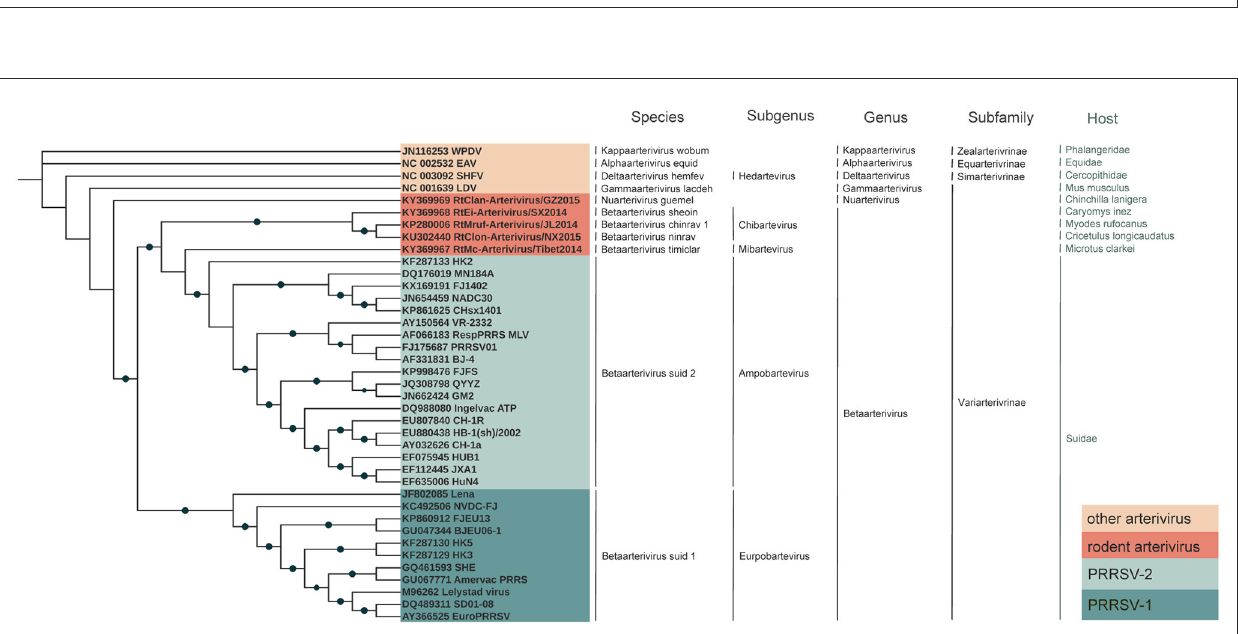
FIGURE5 Phylogenetic analyses of arterivirus. Whole genome trees were constructed by using the maximum-likelihood (ML) method and bootstrap values calculated from 1,000 trees.